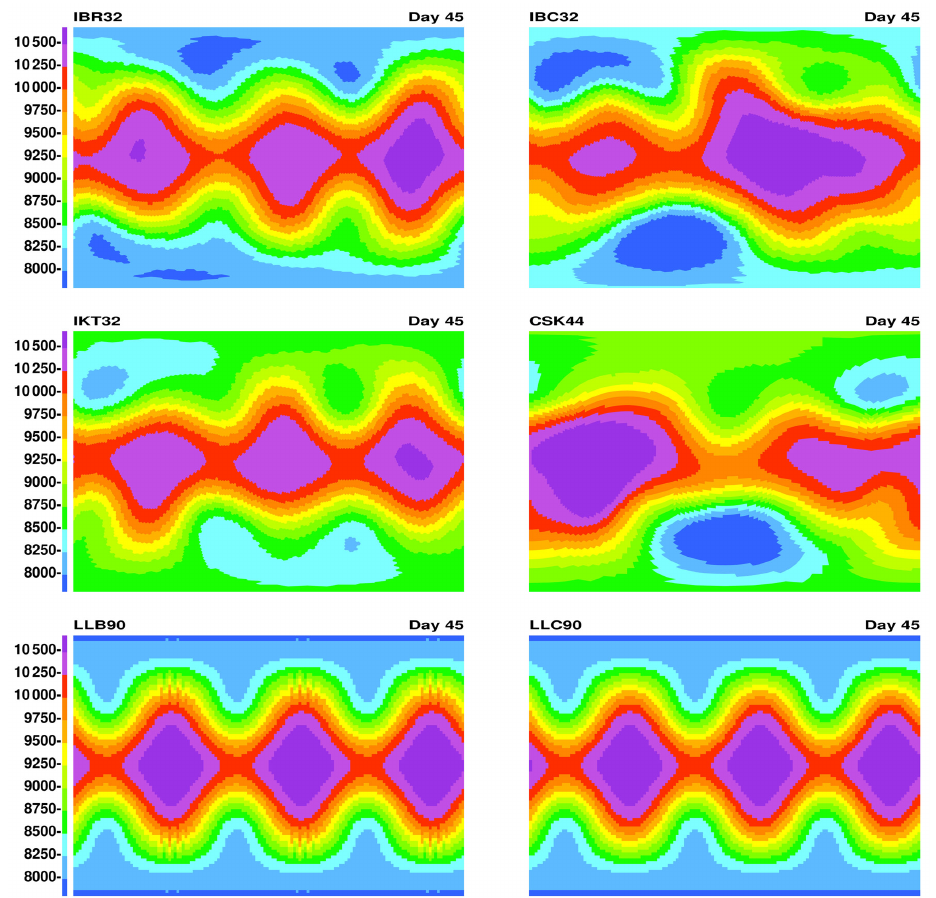
Figure 6. Horizontal plots of h for models IBR, IBC, IKT, CSK, LLB, and LLC at 2 ◦ resolution after 45 days of integration starting from Rossby–Haurwitz wave 3